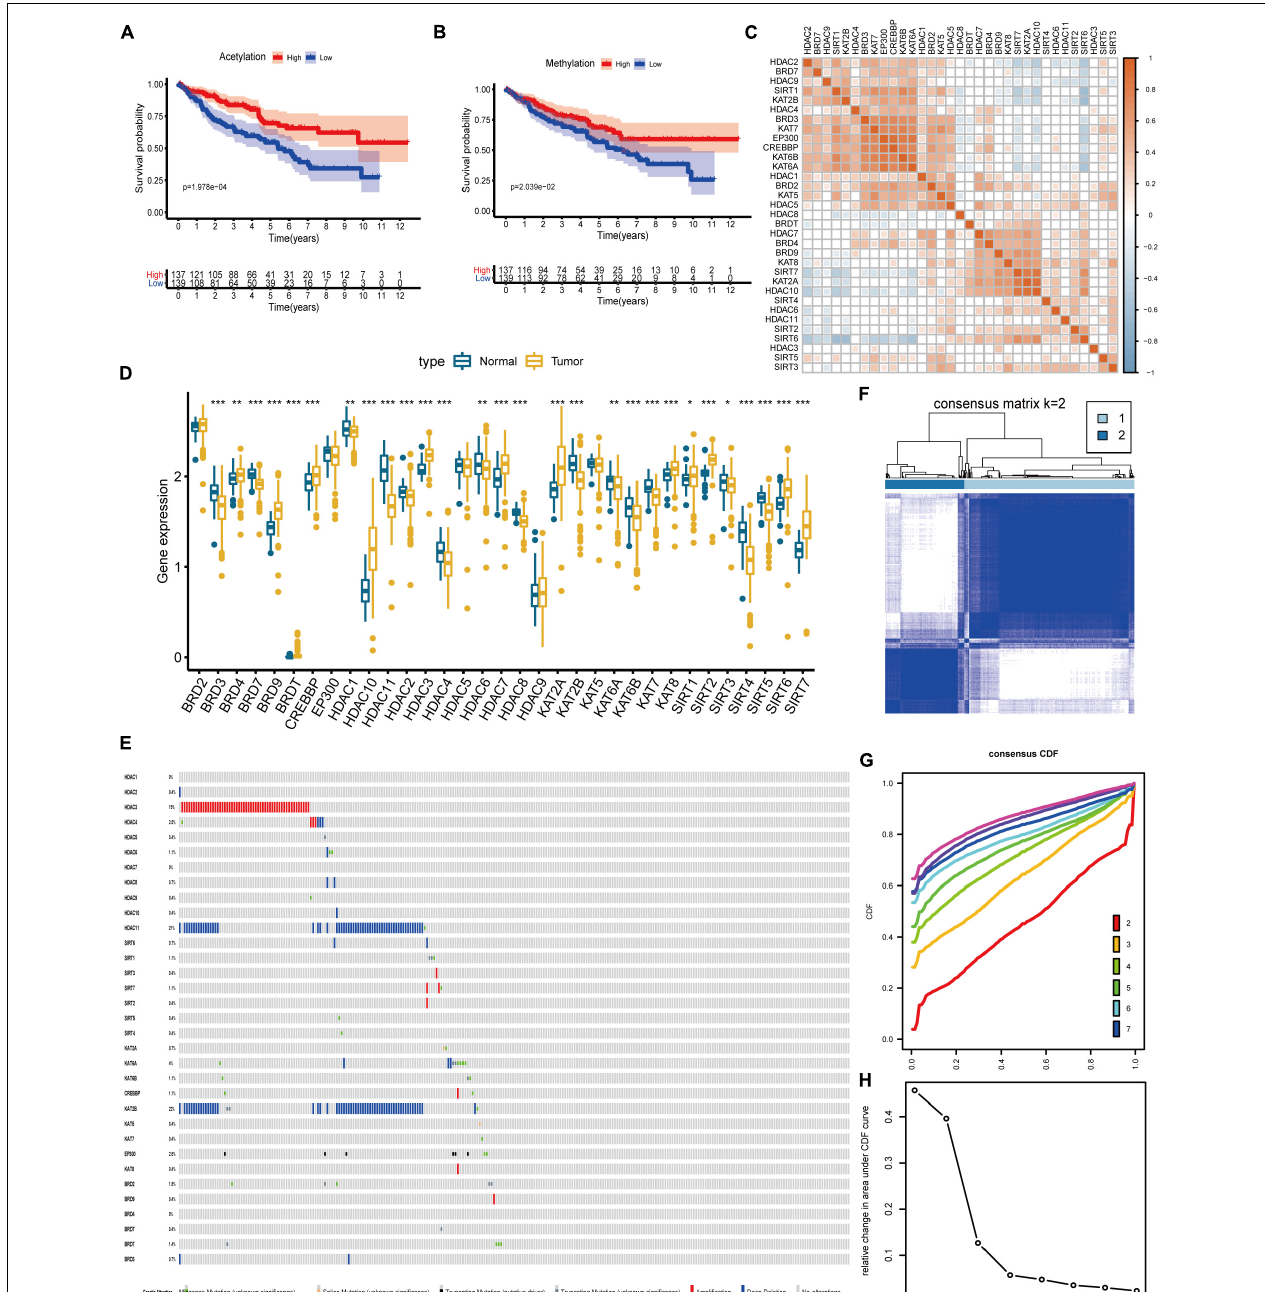
FIGURE 2 | The landscape of histone acetylation regulators in ccRCC and subtype identification (A) Survival analysis between high and low score of acetylation based on ssGSEA. (B) Survival analysis between high and low score of methylation based on ssGSEA. (C) Correlation among 33 histone acetylation regulators. (D) The results of differentially expressed analysis from histone acetylation regulators. * p < 0.05, ** p < 0.01, *** p < 0.001. (E) Data on the somatic mutation and copy number variations of 33 histone acetylation regulators. Panels (F–H) show the most appropriate value for subtype